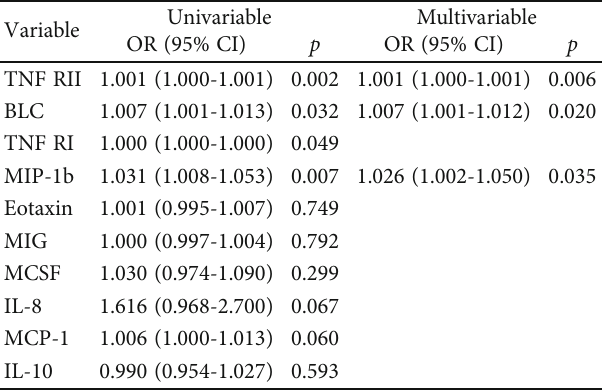
Table 4: Logistic regression analysis of di ff erentiating active SLE from inactive SLE. Univariable Variable